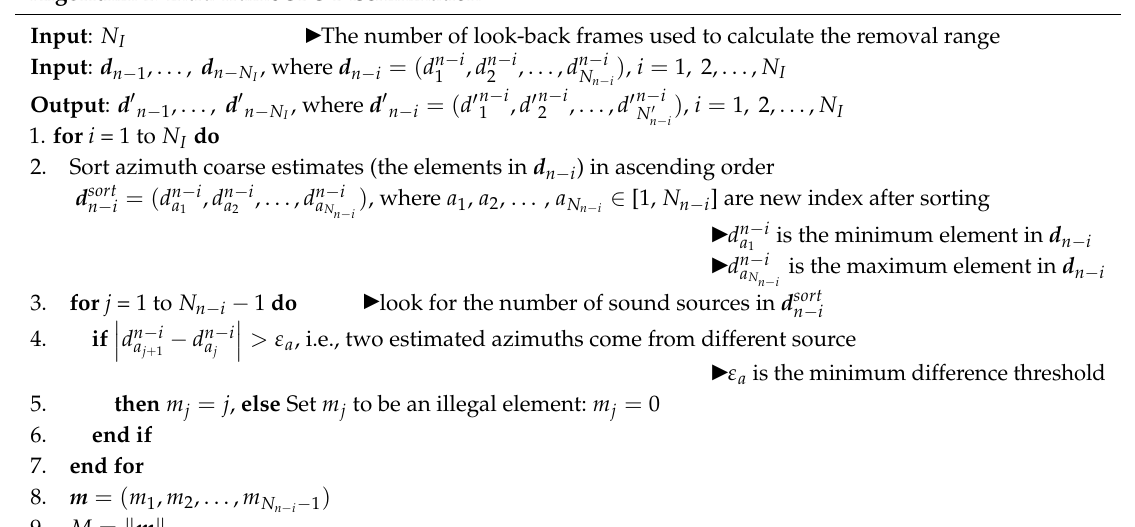
Algorithm 1 : Intra-frame SDS Discrimination